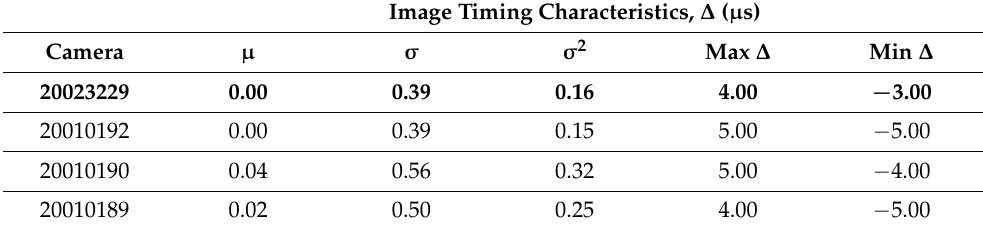
Table A3. Timing differences between camera images during triggered image capture. Camera 20023229 (bolded) is the primary camera sending a trigger signal to each secondary camera. Timings were measured in nanoseconds and converted to